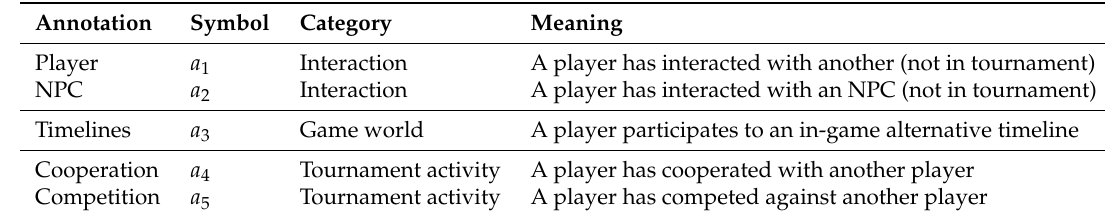
Table 6. Annotations description (Source: See